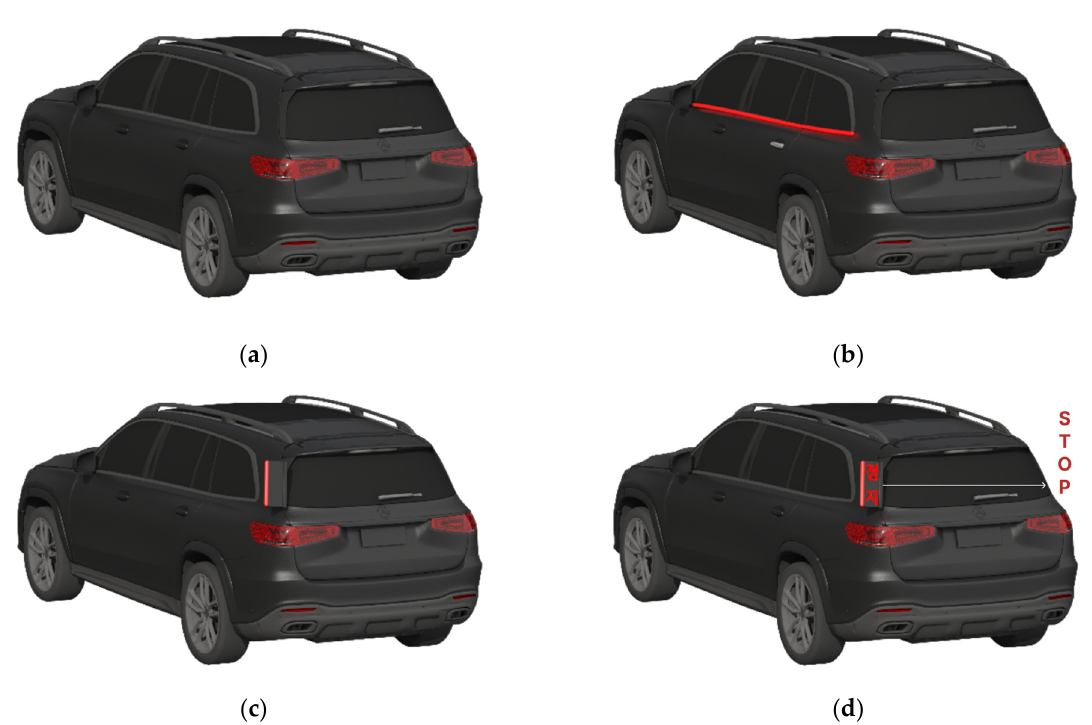
Figure 2. Four tested cases (digital prototype): ( a ) No eHMI; ( b ) Horizontal light band; ( c ) Vertical light band; ( d ) Vertical light band plus text “STOP” wri tt en in Korean.